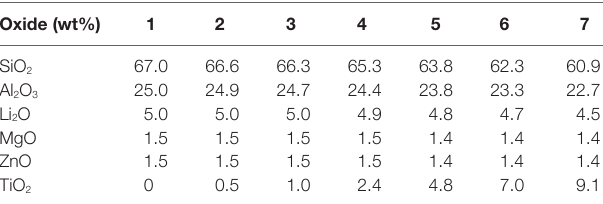
TaBle 1 | glass compositions (wt%) used for the current